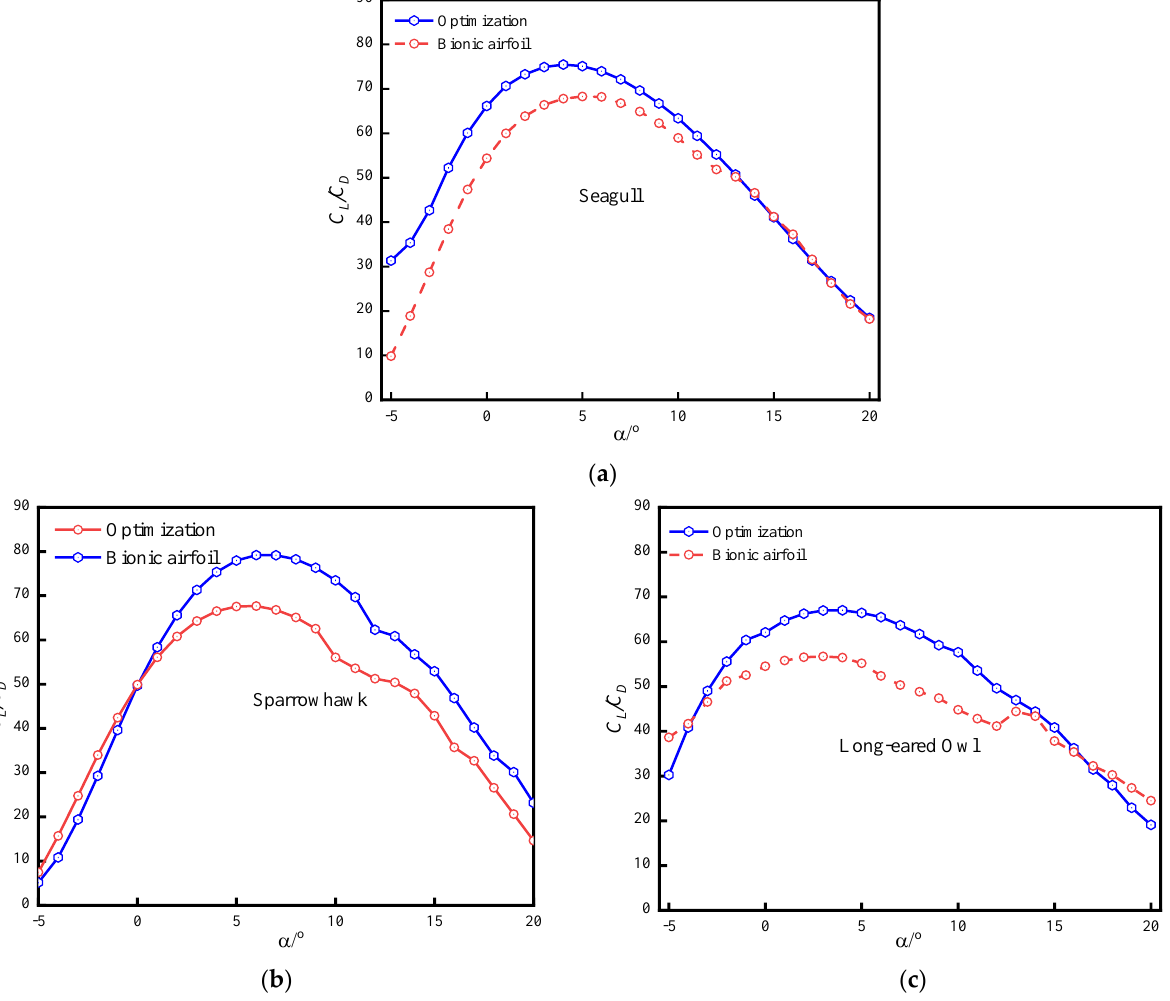
Figure 10. Comparison of lift − drag ratio coefficients before and after optimization of the bionic airfoil. ( a ) Seagull lift − to − drag factor; ( b ) Sparrowhawk lift − to − drag factor; ( c ) Long − eared owl lift − to − drag factor.